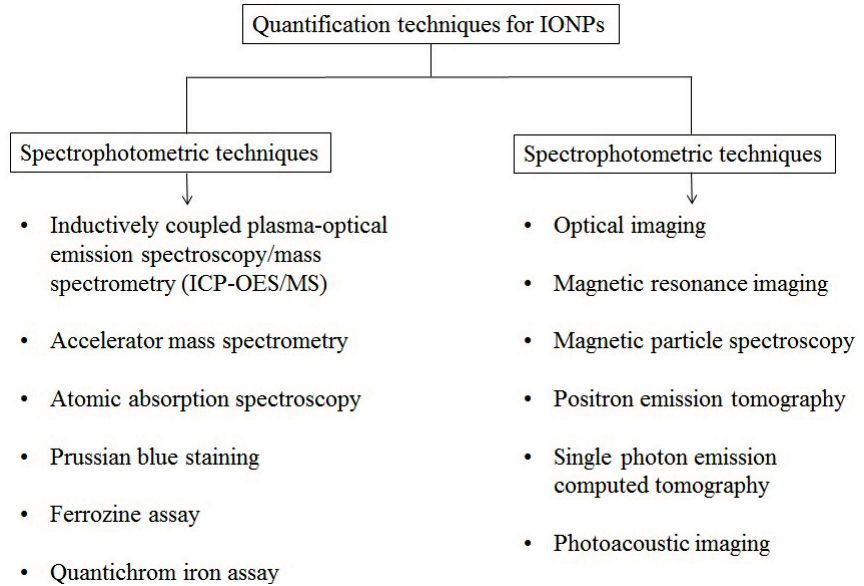
Figure 2. Major spectrophotometric and imaging based quantification techniques for